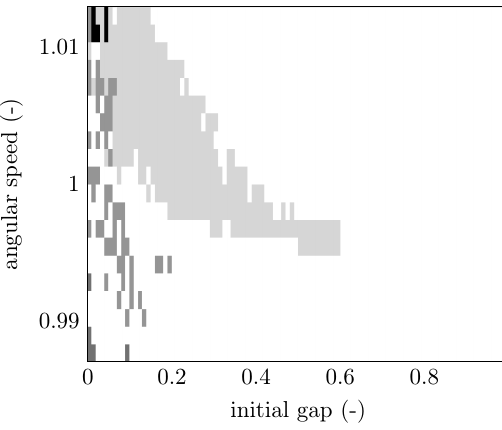
Figure 24. Number of wear lobes depending on the angular speed and the initial clearance for the HP compressor blade. ( ): 5 wear lobes, ( ): 17 wear lobes, ( ): 22 wear